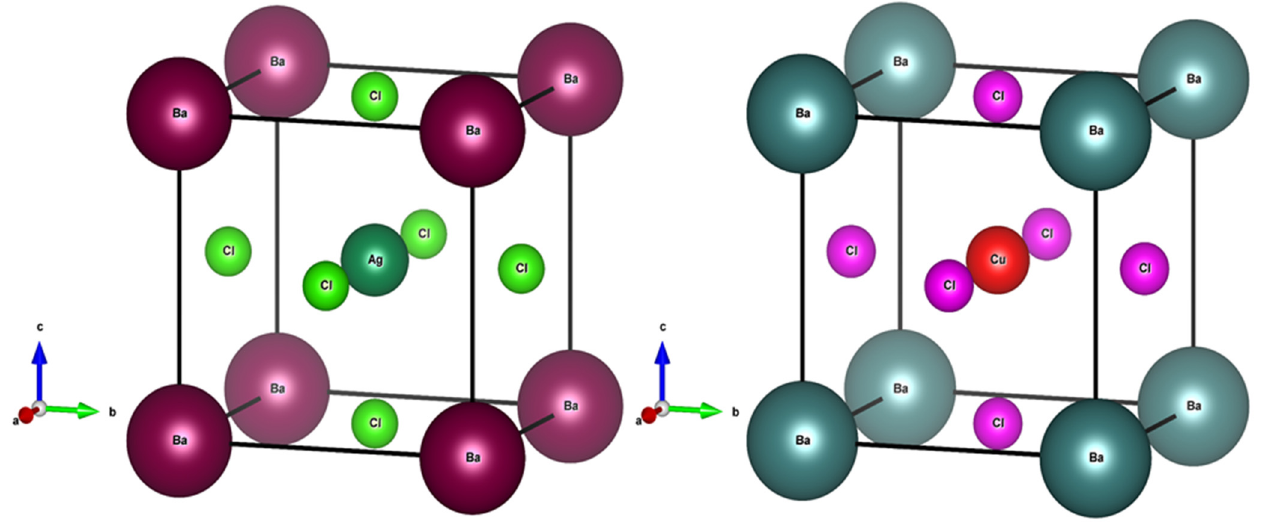
Figure 1. The crystal structures of BaMCl 3 (M = Ag, Cu) compounds.